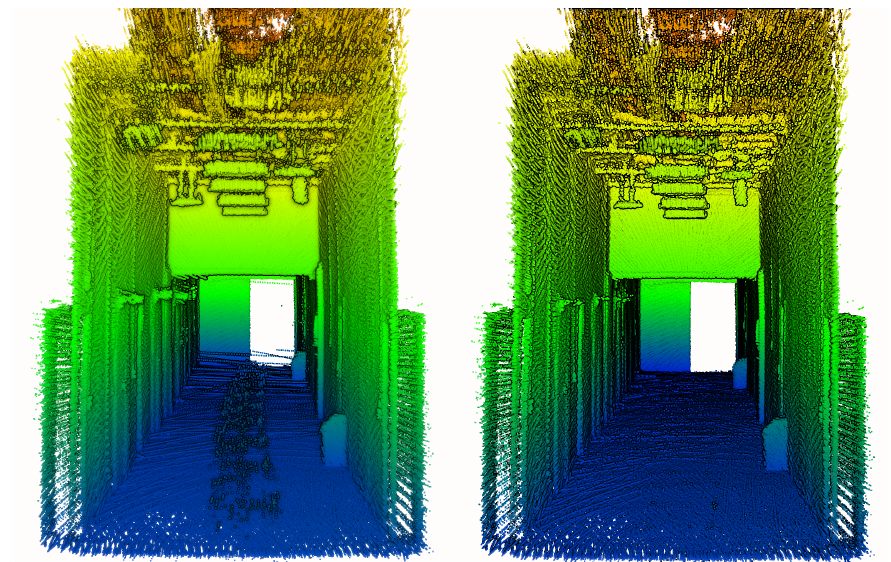
Figure 5. Point cloud before ( left ) and after filtering ( right